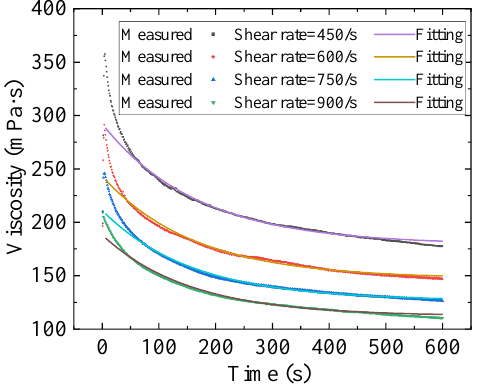
Figure A8. Houska model transient viscosity fitting.